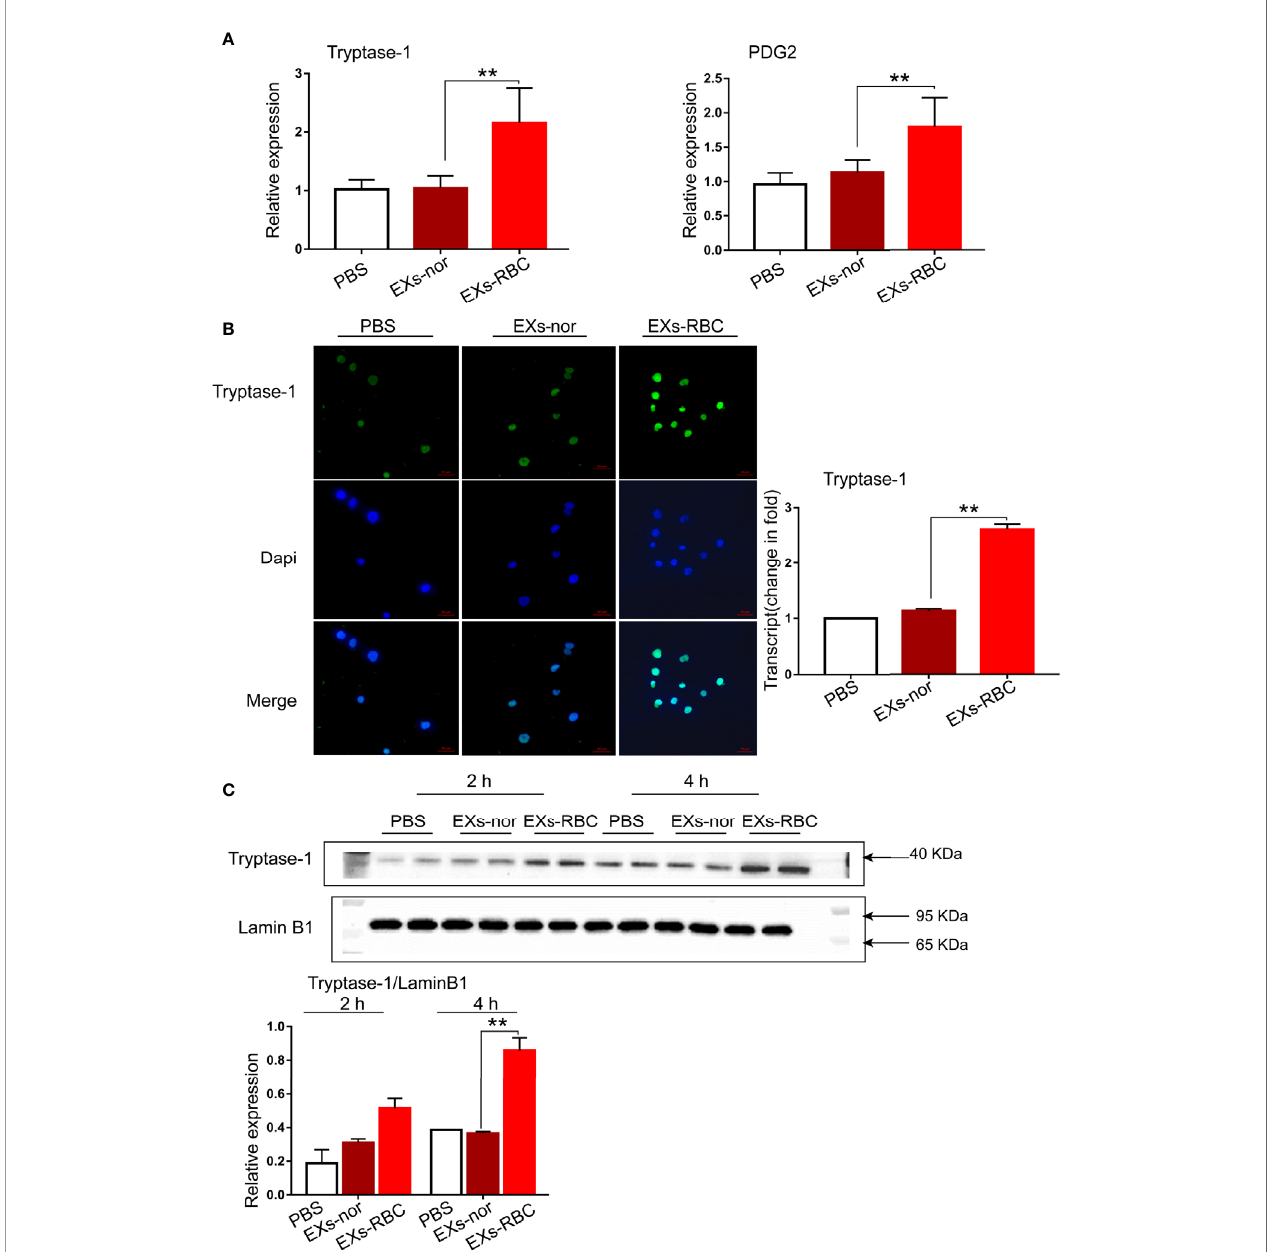
FIGURE 3 | Activation of HMC-1 cells induced by EXs-RBCs. HMC-1 cells were cultivated with PBS, EXs-nor, and EXs-RBC for 2 h, and qPCR and Immuno fl uorescence were performed. At 2 h and 4 h after incubation, western blotting was employed. Data were from 2 – 4 independent trials. ANOVA and multiple comparisons were used to measure the differences between EXs-nor and EXs-RBC groups. * indicates statistical difference between groups (**P < 0.01). (A) The expression of tryptase-1 and PGD-2 mRNA in HMC-1 cells increased in the EXs-RBC group. (B) Left pictures are the representative panels of Immuno fl uorescence. Right panel: immuno fl uorescence results were quanti fi ed with Image J software. (C) Representative western blotting images (upper panels). Blots were quanti fi ed using Image J (lower panel). EXs-nor, exosomes from normal volunteer plasma; EXs-RBC, exosomes from red cell